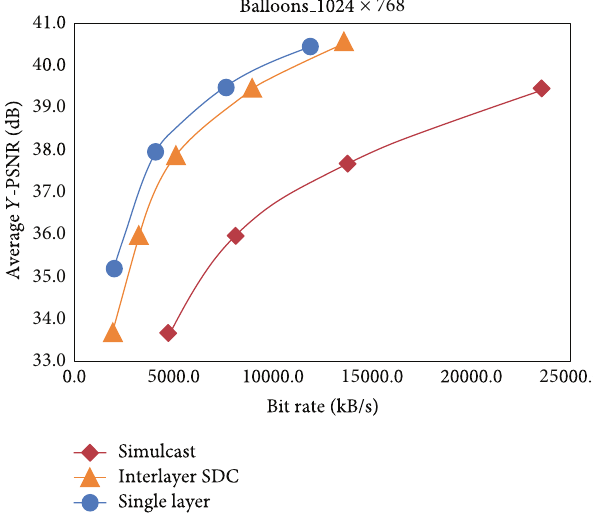
Figure 5: Performance comparison for balloons.